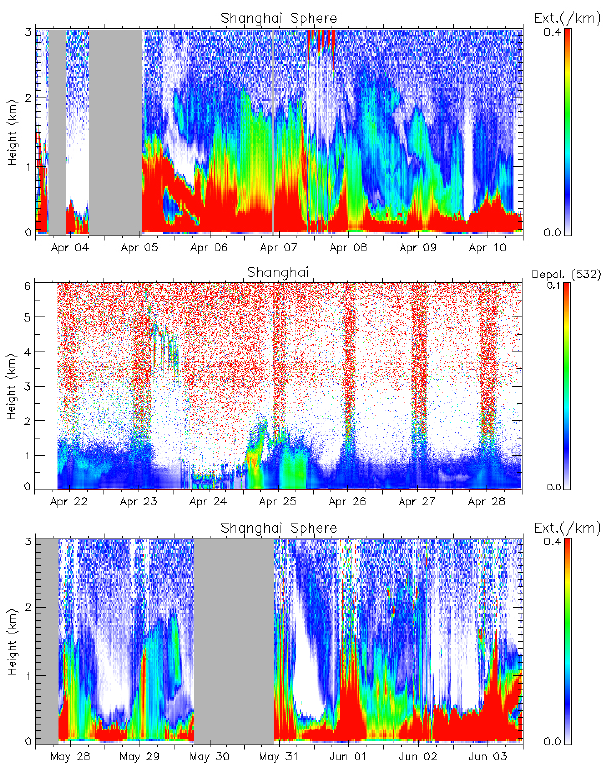
Fig. 8. Top panel: The time-height cross section of spheric aerosol extinction coefficient (km -1 ) during PE1. Middle panel: The time-height cross section of depolarization ratio from 22-28, April, including PE2 (25 April). Bottom panel: The time-height cross section of spheric aerosol extinction coefficient (km -1 ) during PE3. The gray columns represented the missing data which were due to the malfunction of the lidar instrument.